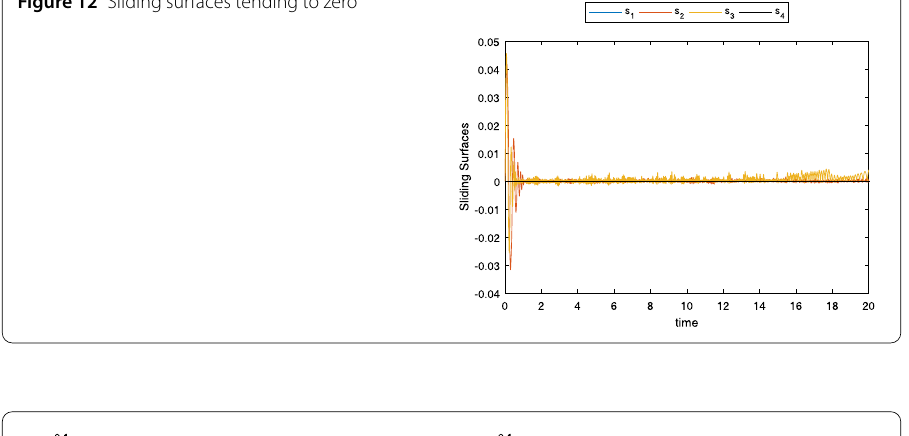
Figure 12 Sliding surfaces tending to zero